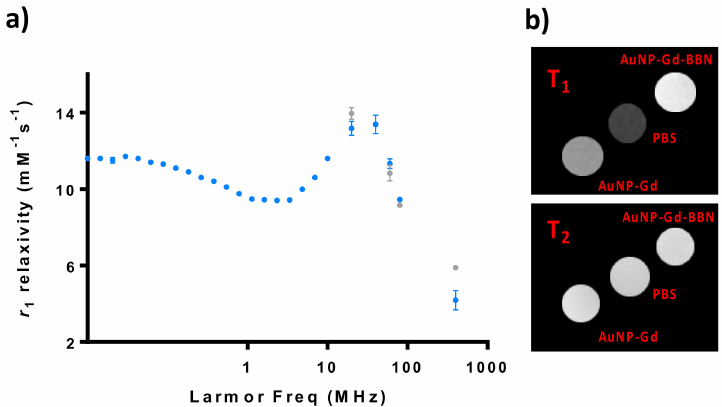
Figure 1. Relaxometric and MRI studies of AuNP-Gd and AuNP-Gd-BBN particles: ( a ) 1 H NMRD profiles of AuNP-Gd ( • ) and AuNP-Gd-BBN ( • ) (25 ◦ C); ( b ) T 1 - and T 2 -weighted MRI phantom images obtained at 9.4T (25 ◦ C): [Gd] AuNP-Gd = 0.25 mM and [Gd] AuNP-Gd-BBN = 0.22 mM.